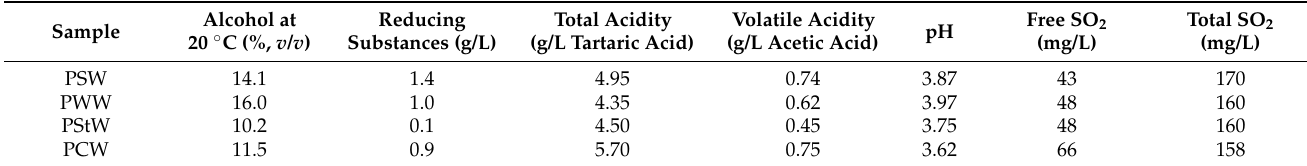
Table 4. Physicochemical analysis of piquettes